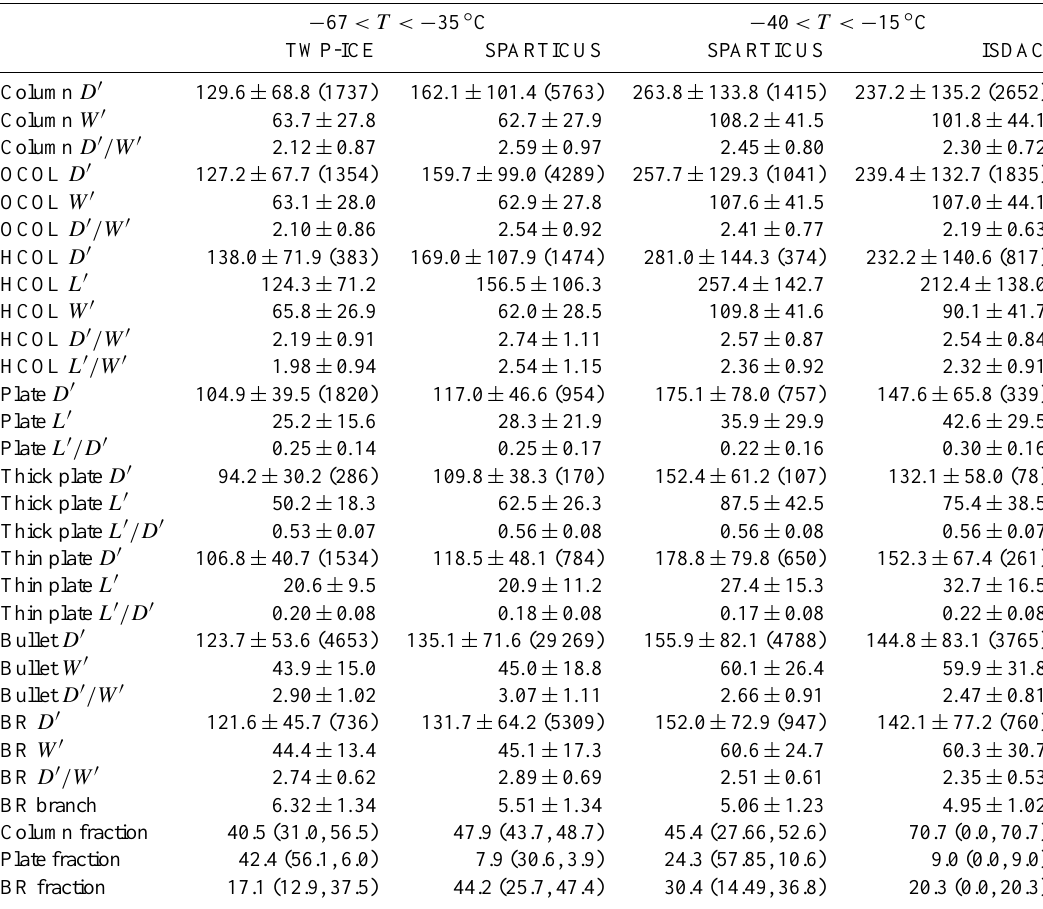
Table 7. A comparison between dimensions (µm), aspect ratios, and occurrence frequency (%) of columns, plates, bullets, and bullet rosettes (BR) at − 67 < T < − 35 ◦ C (TWP-ICE vs. SPARTICUS) and at − 40 < T < − 15 ◦ C (SPARTICUS vs. ISDAC). Mean and standard deviation of dimensions and aspect ratios are shown. The numbers in parentheses indicate the number of samples for each category. The occurrence percentage is normalized by the total number of columns, plates, and bullet rosettes, and the fraction in all clouds (fraction in anvil clouds, fraction in non-anvil clouds) is